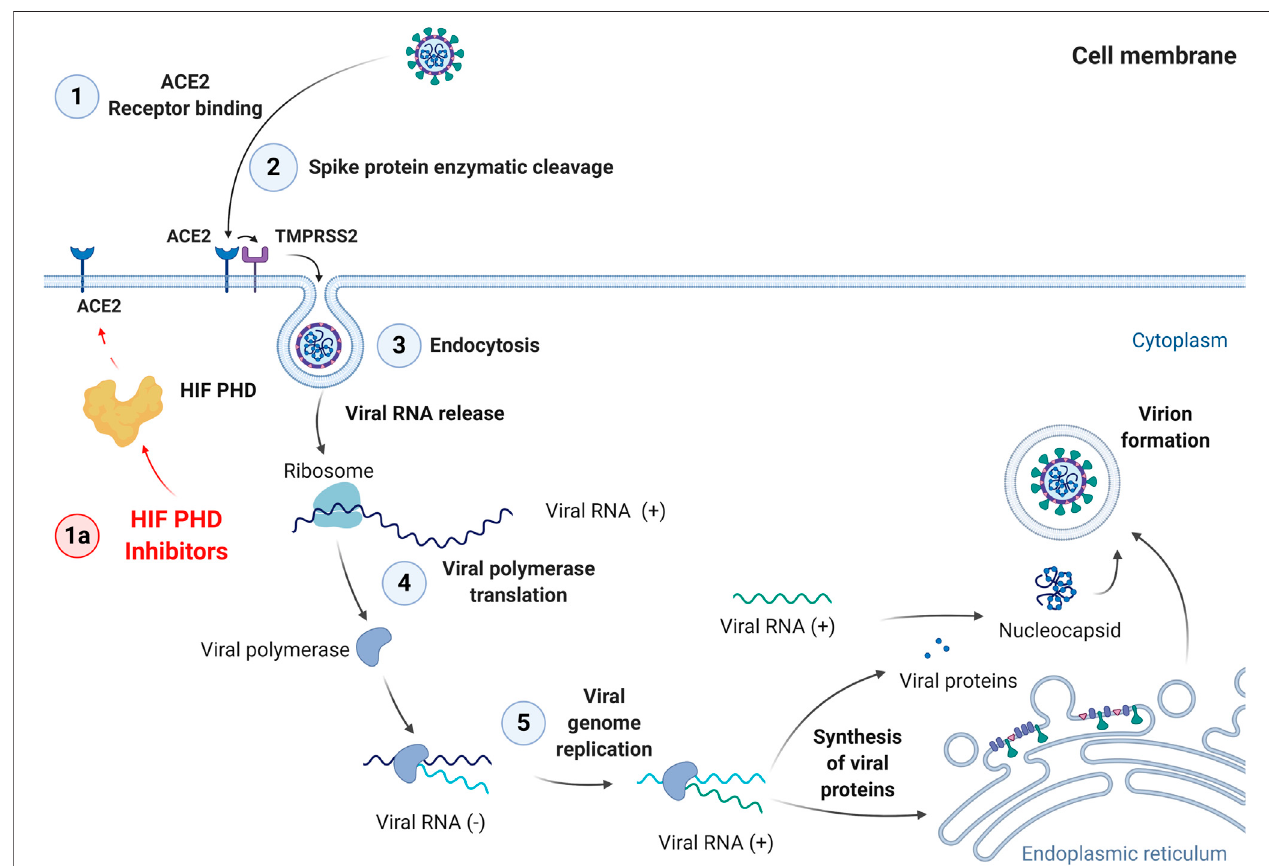
FIGURE 3 | Steps of SARS-Cov-2 cell entry and replication cycle. 1: Binding to ACE2 receptor; 2: Enzymatic cleavage of Spike protein; 3: Endocytosis; 4: Viral polymerase translation; 5: Viral genome replication. The last step is followed by synthesis of viral proteins, virion formation, and exocytosis.